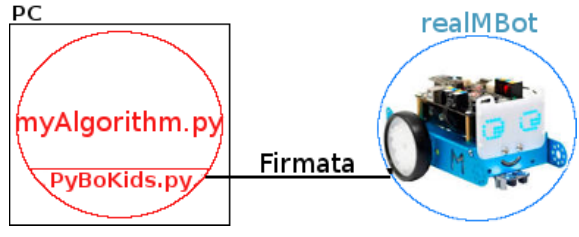
Figure 4. Software robot brain in Python. Table 1. PyBoKids.py application programming interface.